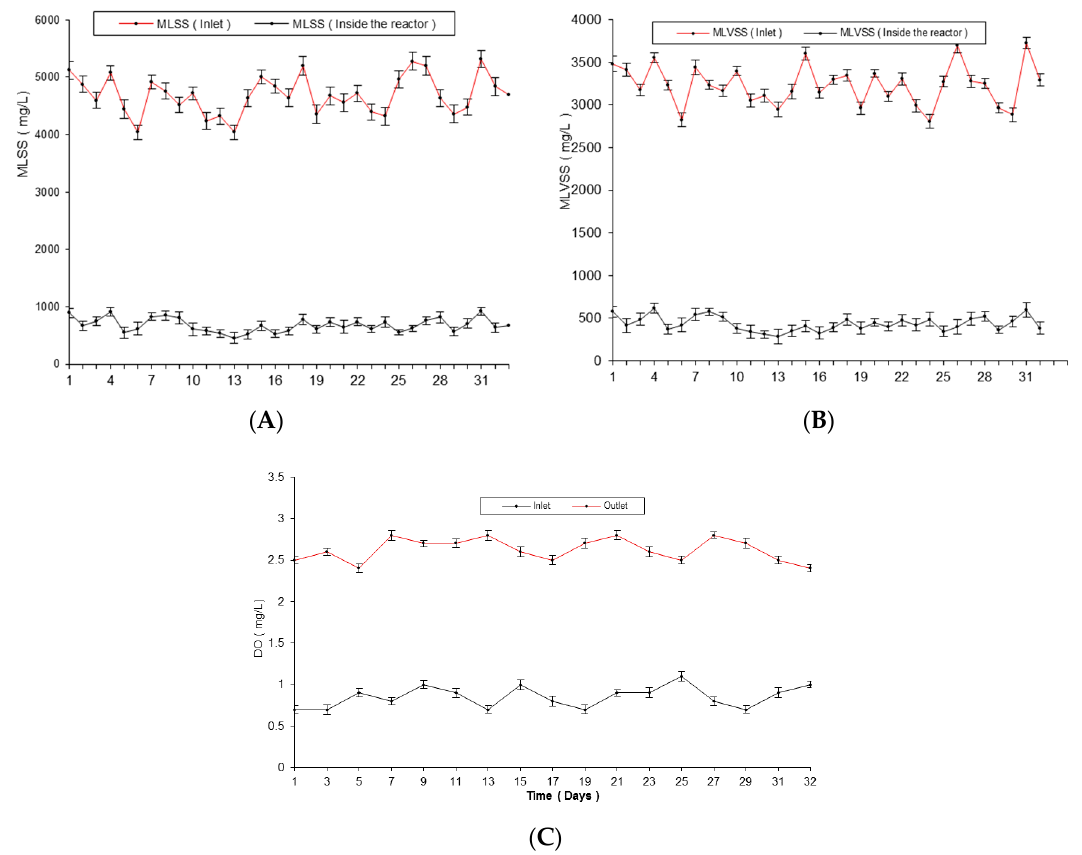
Figure 3. ( A ) MLSS profile in continuous mode aerobic digester (ASP sludge); ( B ) MLVSS profile in continuous mode aerobic digester (ASP sludge); ( C ) DO profile in continuous mode aerobic digester (ASP sludge).